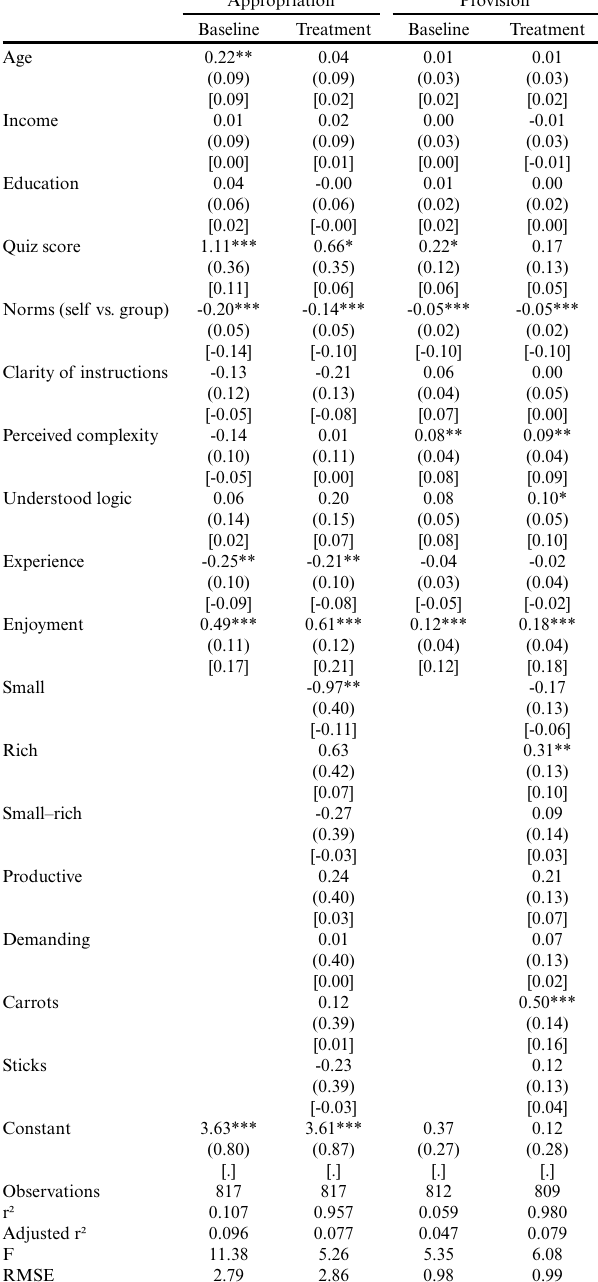
Robust standard errors in parentheses. Standardized coefficients in square